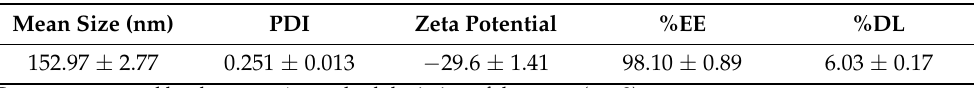
Table 1. Mean diameter, polydispersity index (PDI), zeta potential, encapsulation efficiency (%EE), and drug loading (%DL) for LPNP-TS-DOX.